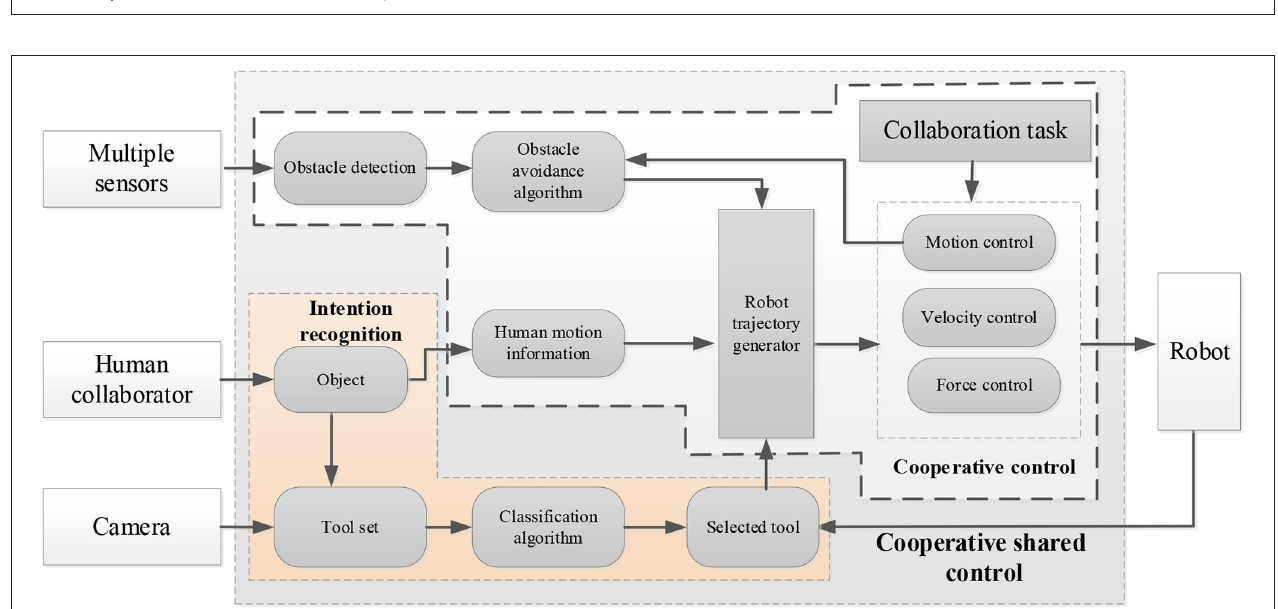
FIGURE 2 | Outline of the proposed